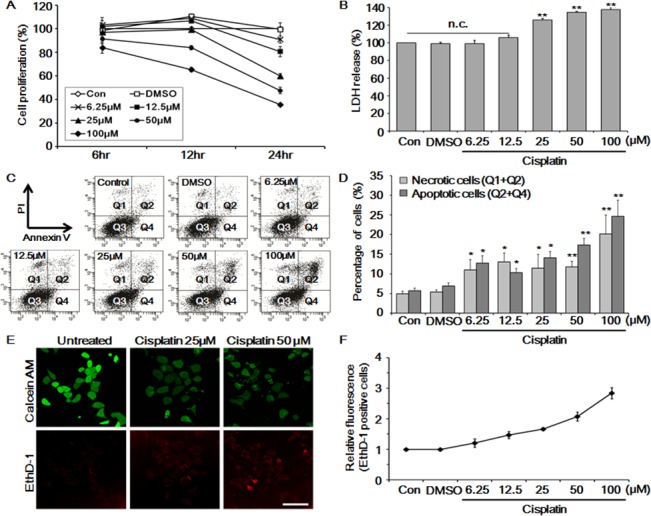
Evaluation of cellular toxicity and viability in cisplatin-treated HK-2 cells.HK-2 cells were treated with increasing concentrations of cisplatin (6.25–100 μM). (A) HK-2 cell proliferation was assessed by MTS assay after 6, 12, and 24 h of cisplatin treatment. (B) Cells were treated with the indicated concentrations of cisplatin for 24 h and cell death was measured. (C and D) HK-2 cells were washed twice with cold phosphate-buffered saline (PBS), stained with Annexin V/propidium iodide (PI), and cell death was determined by flow cytometry. (E and F) Cisplatin-induced cell viability and cytotoxicity assay using calcein AM and ethidium homodimer (EthD-1) fluorescence staining with confocal microscopy (E) and flow cytometry (F). Magnification of the images was ×40 and scale bars represent 75 μm. The mean ± S.D. (standard deviation) of three independent experiments are presented; *p < 0.05, **p < 0.01, by paired t-test.